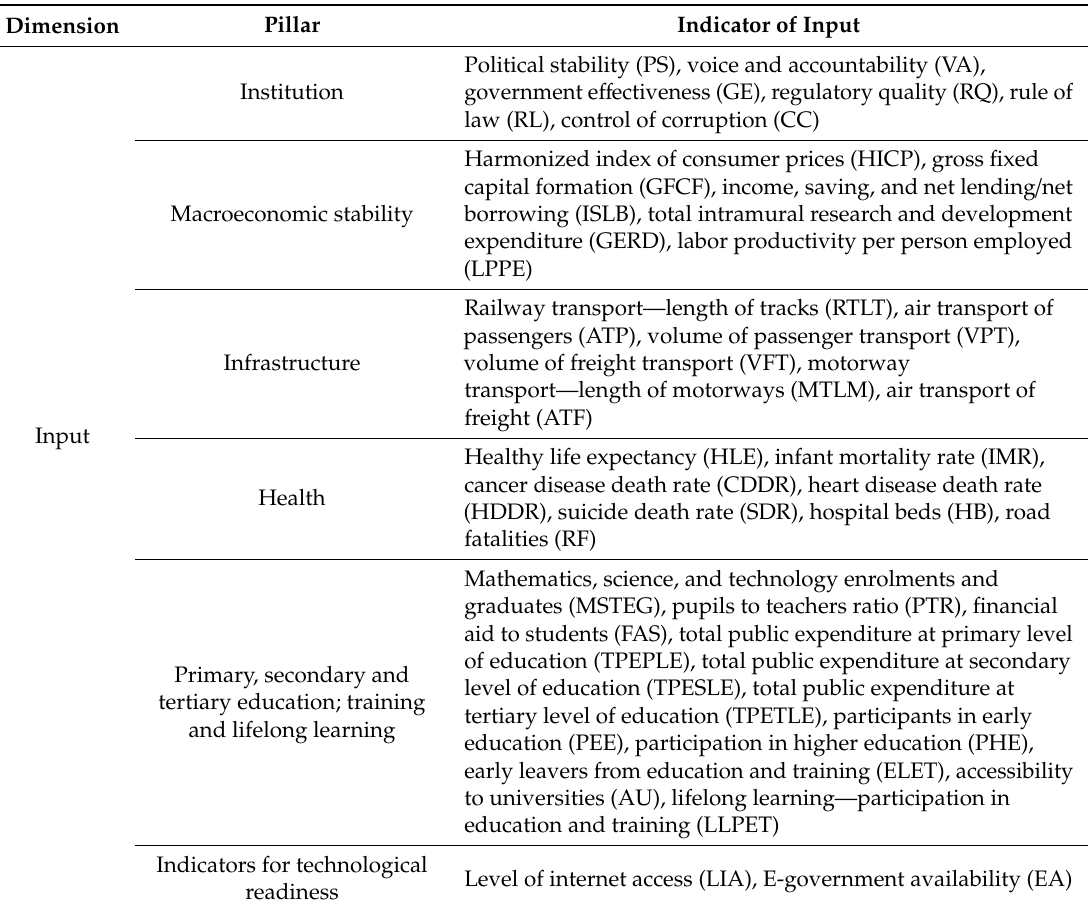
Table 2. Country competitiveness index (CCI) indicators in input and output dimensions * (source: own